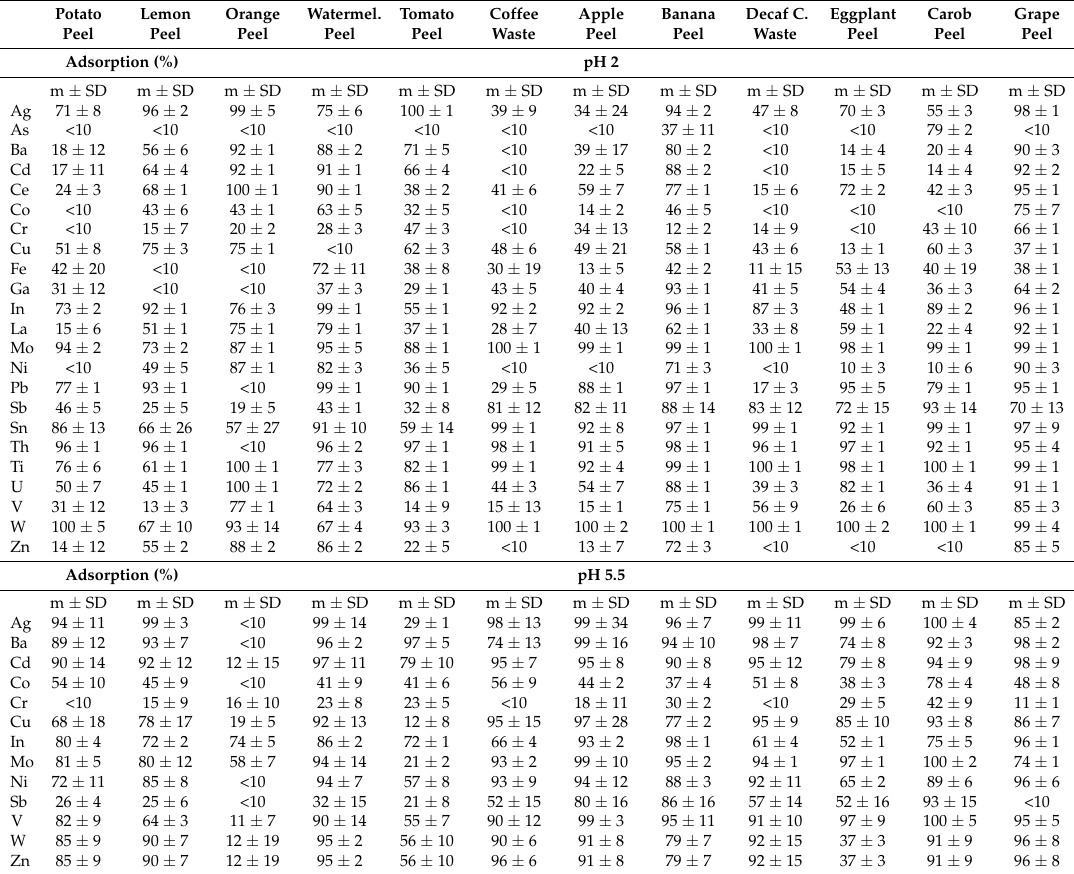
Table 1. Removal efficiency of the food waste adsorbents (200 mg) from multi-element synthetic solutions at pH 2.0 and pH